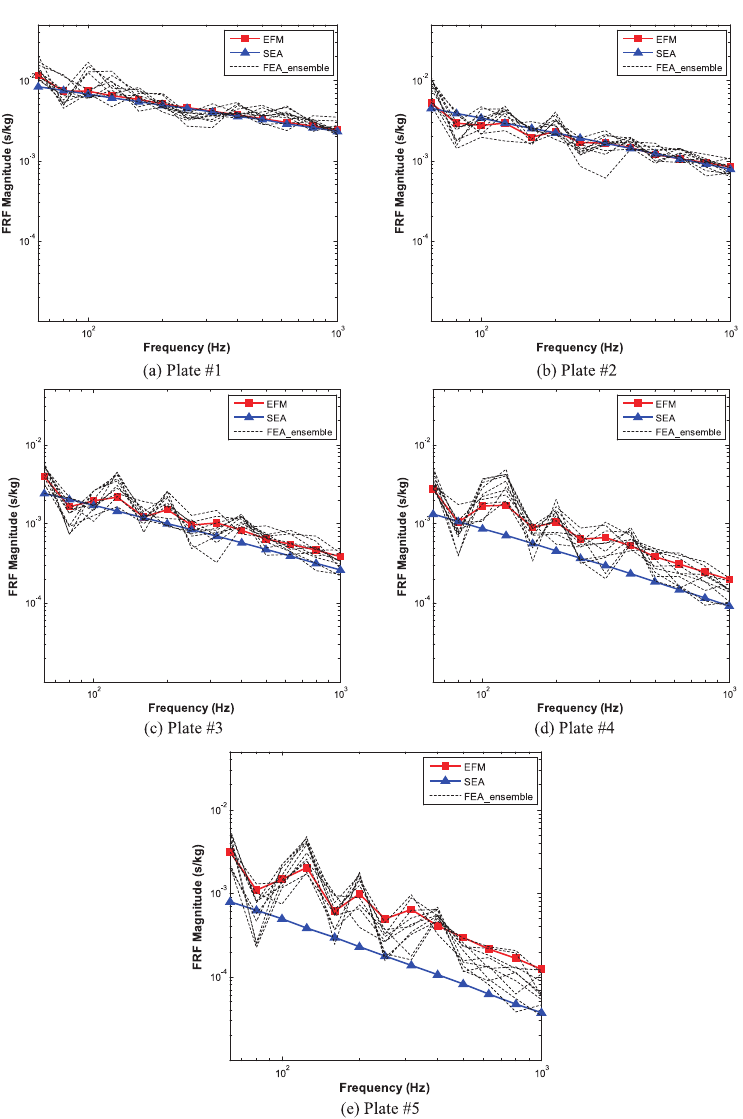
Fig. 12. EFM FRF comparison with SEA and FEA ensemble: For the FEA ensemble, each dotted line represents a spatial average over the FRF magnitudes on the corresponding panel for each force input (a total of 10 inputs on panel #1 are used). [0 , π ] with respect to the line interface. Thus for the perpendicularly connected plates, the transmission across the interface line is a function of the angle of incidence and the average value of the coupling loss factor over incident angles can be written